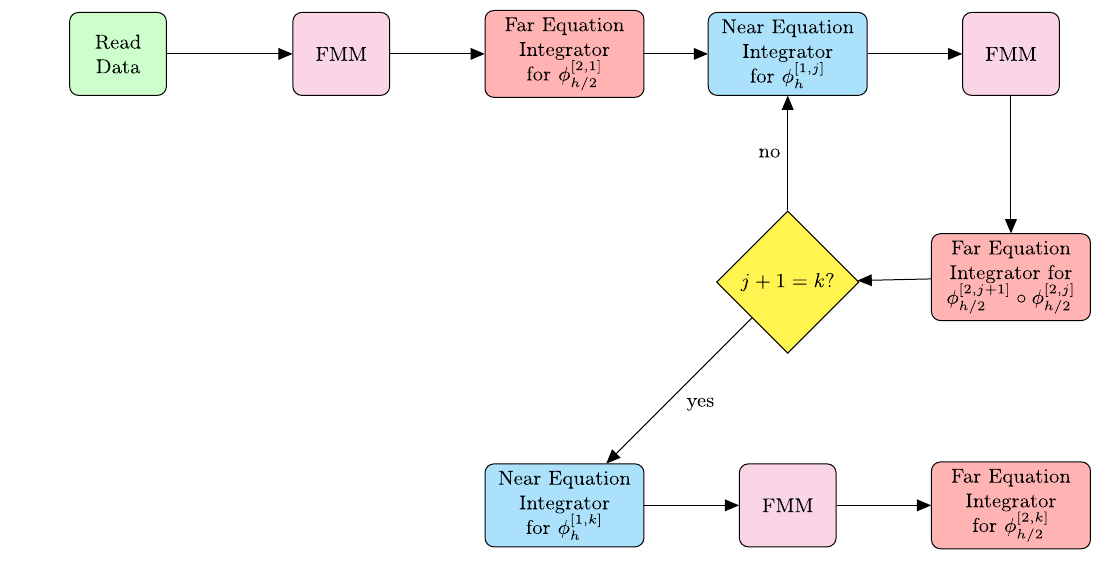
ns.FIG. 1. A flow chart of the PHAD